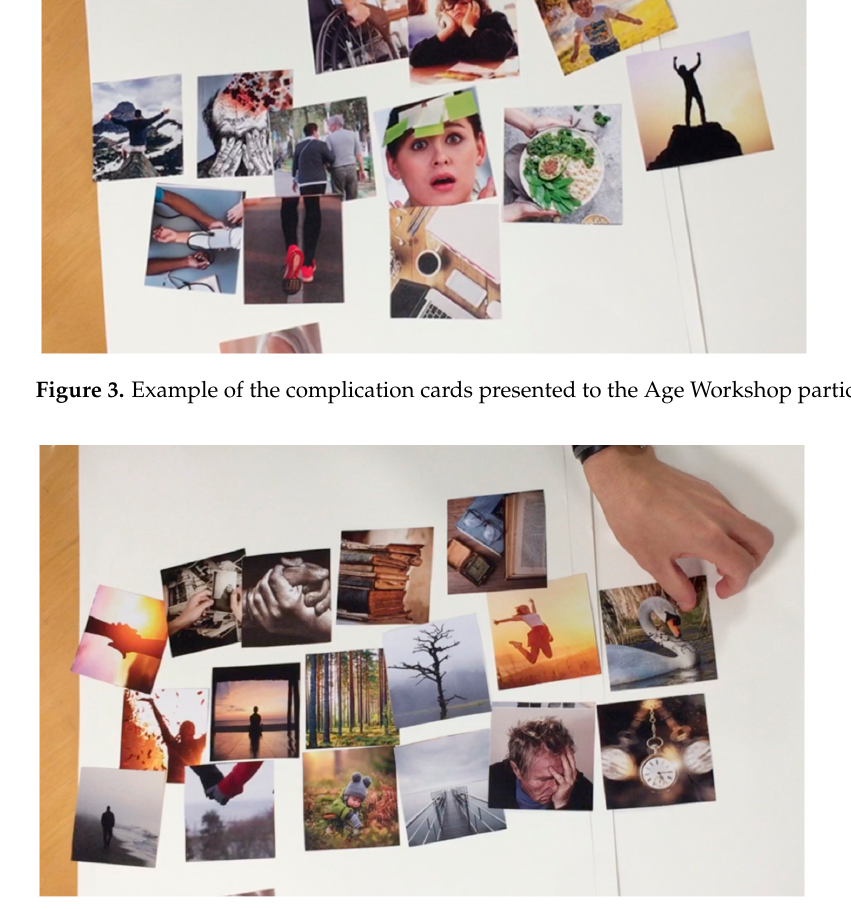
Figure 4. Example of the evaluation cards presented to the Age Workshop participants.